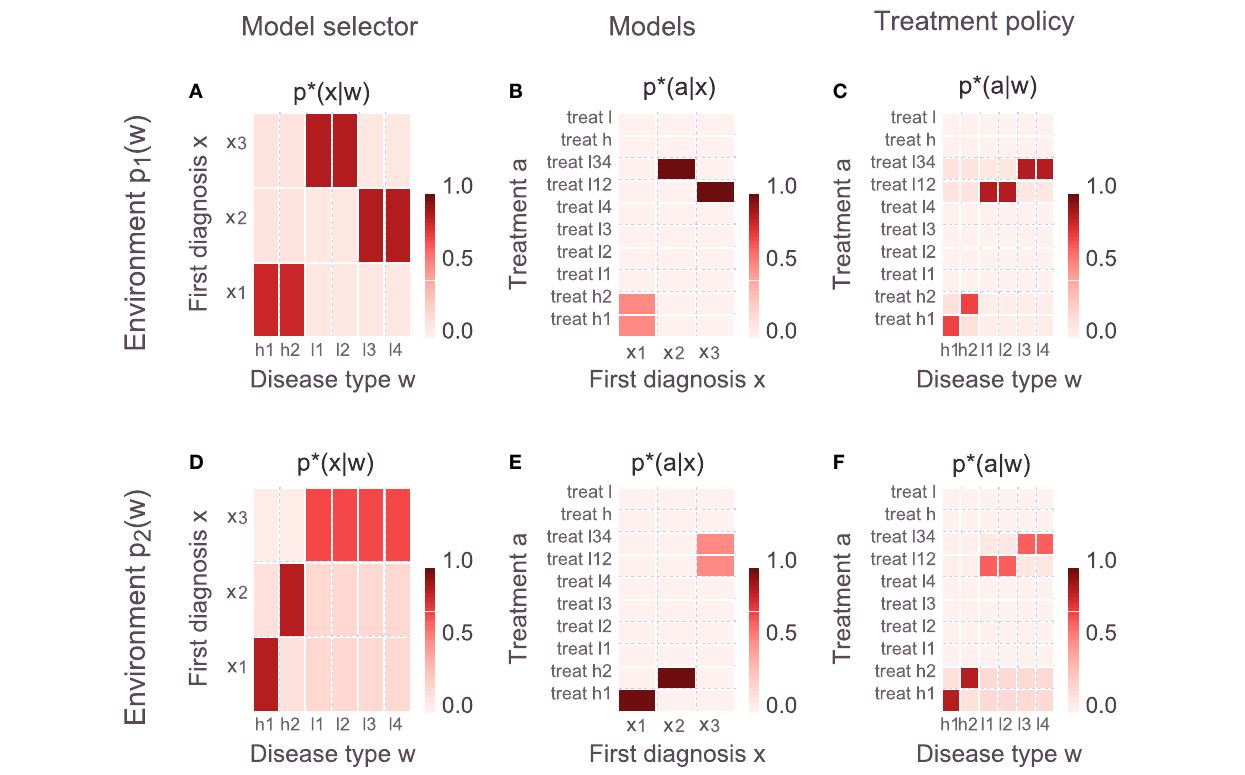
FIGURE 10 | Bounded-optimal hierarchies for two different environments (different p ( w )) . Top row: all disease types are equally probable, bottom row: heart diseases and thus h 1 and h 2 are more probable. (A,D) Optimal model (or specialist) selectors [equation (26)]. In the uniform environment it is optimal to have one specialist for each disease category (heart, lung A, and lung B) and have a model selector that maps specific disease types to the corresponding specialist x . In the non-uniform environment it is optimal to have one specialist for each of the two types of the heart disease ( h 1, h 2) and another one for all lung diseases. The corresponding model selector in the bottom row reflects this change in the environment. (B,E) Optimal models [equation (29), each column corresponds to one specialist]. The resources of the specialists are very limited due to a very low (cid:12) 3 , meaning that the average deviation of p *( a | w , x ) from p *( a | x ) must be small. In the uniform environment it is optimal that the heart specialist spends all the resources for discriminating between the two heart disease types because using the general heart treatment on both types is less effective compared to using one of the lung disease treatments on both corresponding types. In the non-uniform environment this is reversed as the specialists for h 1 and h 2 do not need any more measurements to determine the correct treatment, however, the remaining budget (of 1bit) is spent on discriminating between the two categories of lung diseases (but is insufficient for discriminating between the four possible lung disease types). (C,F) Overall-behavior of the hierarchical system p *( a | w ) =(cid:6) x p *( x | w ) p *( a | w , x ). The distributions p *( a | w , x ) [equation (28)] are not shown in the figure but can easily be investigated in the Supplementary Jupyter Notebook